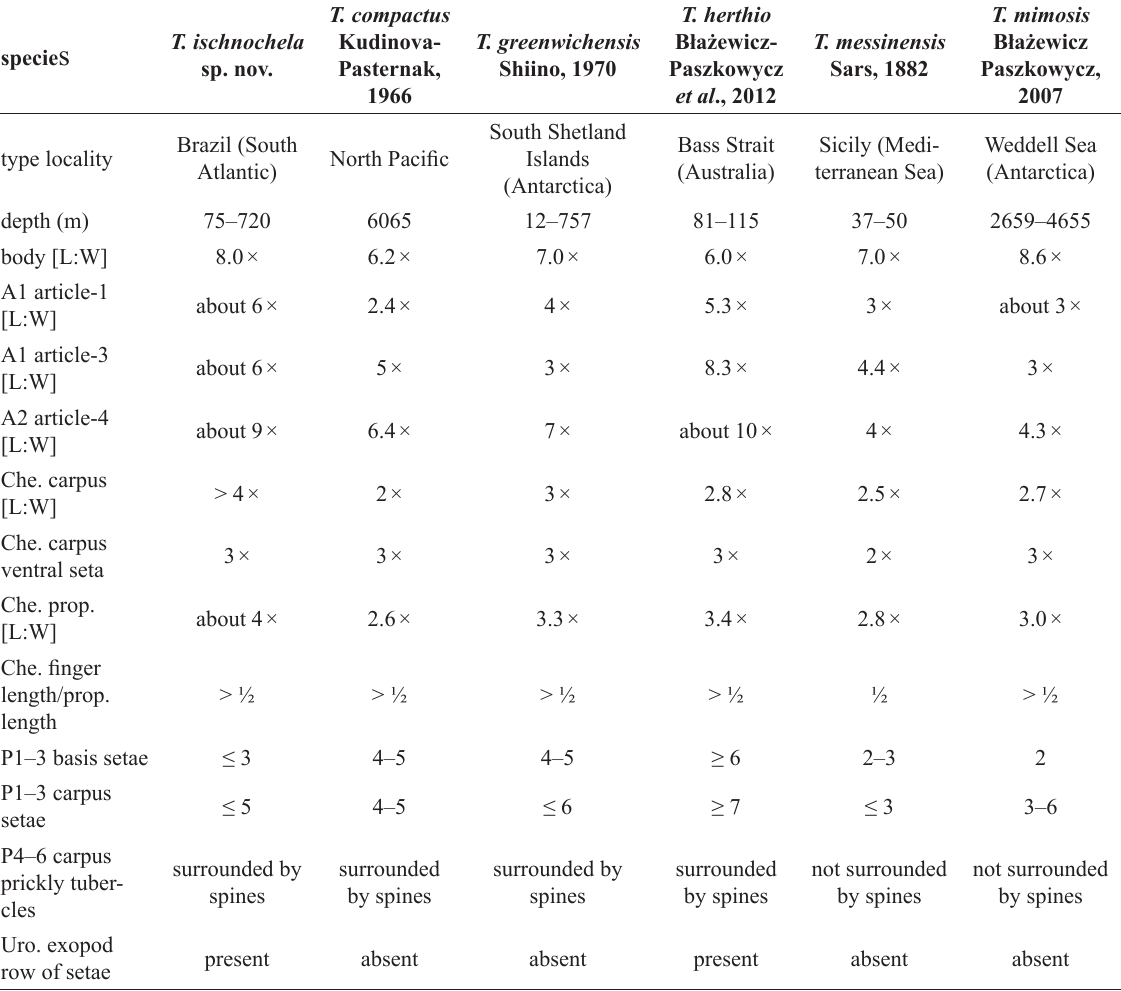
Table 3. Diagnostic characters of species of Typhlotanais ‘ greenwichensis ’ group (based on females). Abbreviations: A1 = antennule; A2 = antenna; Che = cheliped; P = pereopod; Prop = propodus; Uro =